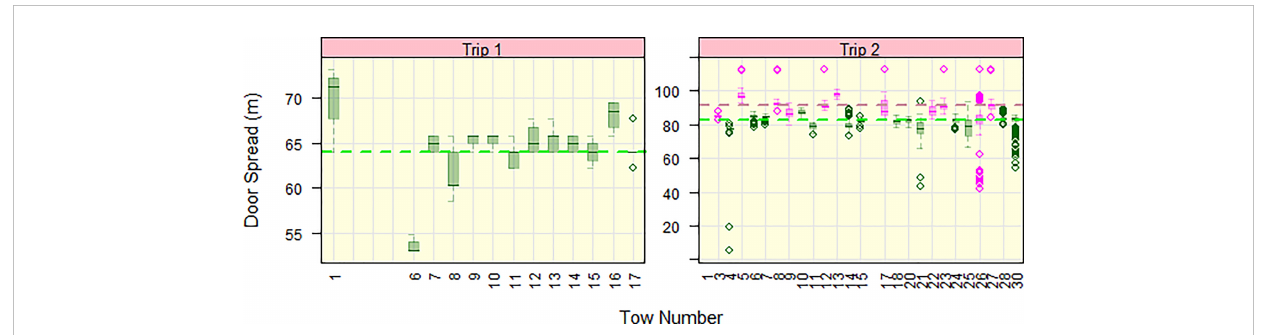
FIGURE 4 Door spreads (y-axis) by tow (x-axis) and trip (panels) from Simrad sensors. Boxes are colored by net type (green=OBT net, pink=Ruhle trawl). Dashed lines are the panel medians and colors of lines match the associated net type. Box widths represent the sample sizes within tows. Trip 1,